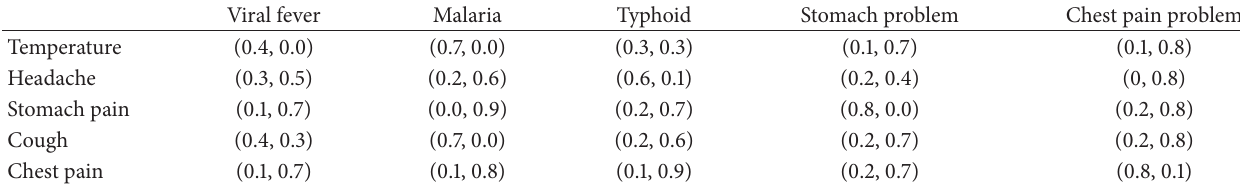
Table 4: Symptoms characteristic for the diagnoses.